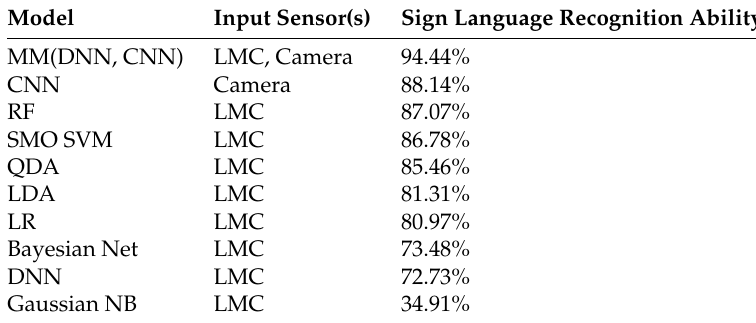
Table 4. Comparison of other statistical models and the approaches presented in this work.;